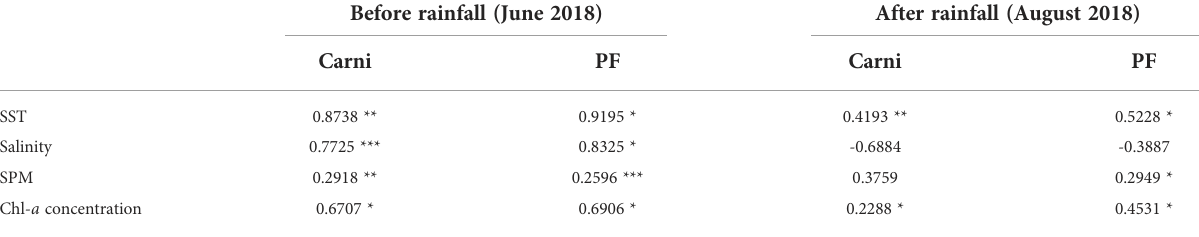
TABLE 4 Pearson correlation between the abundance of feeding habit groups on zooplankton and environment factors.